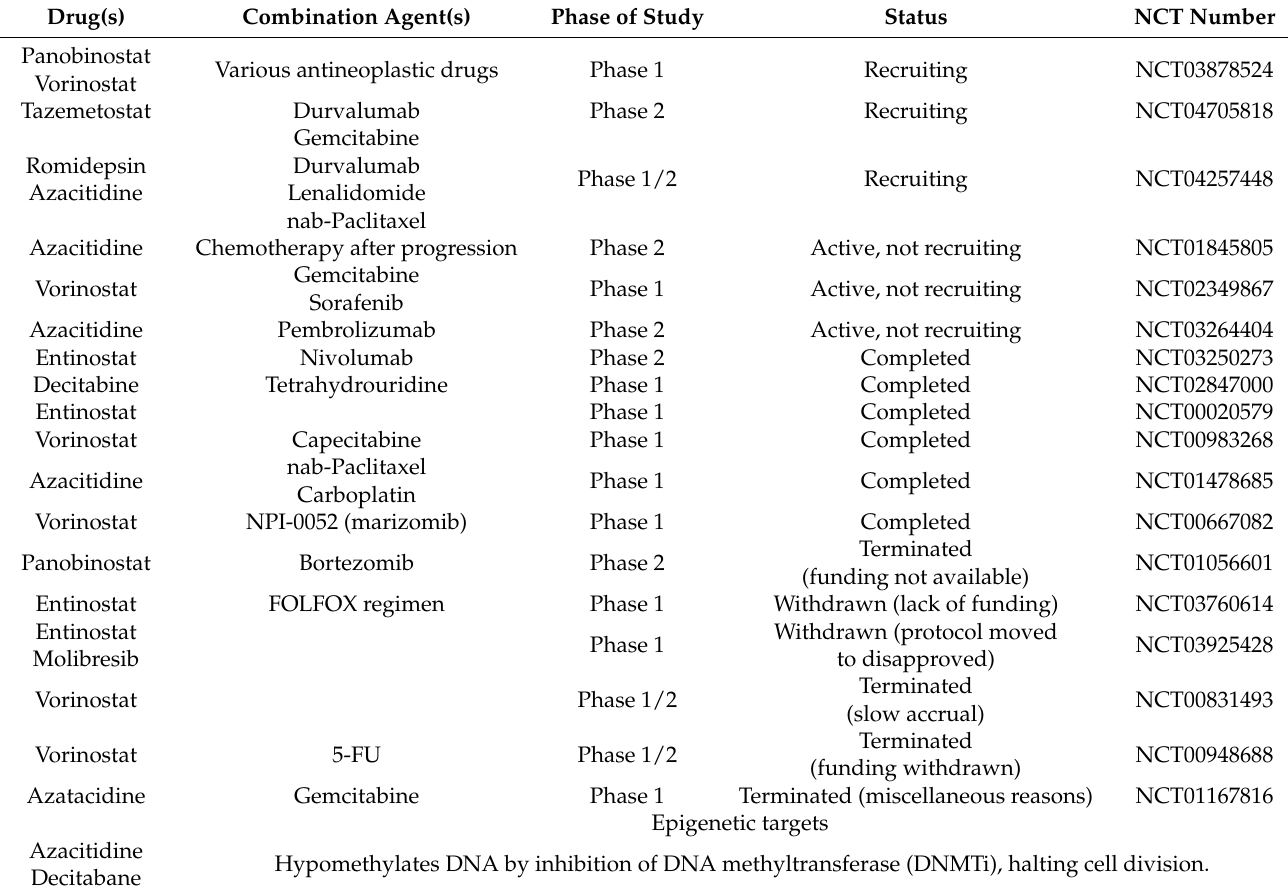
Table 1. List of current and prior trials with epigenetic therapies in PDAC.